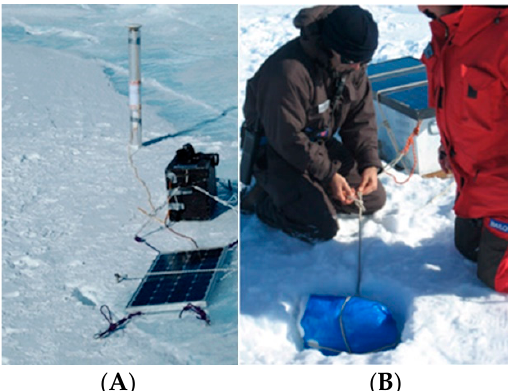
Figure 2. ( A ) DRY1 semi-permanent GNSS station monumented on ice; ( B ) anchoring the instrument box and the solar panel to a dead body buried in the ice.